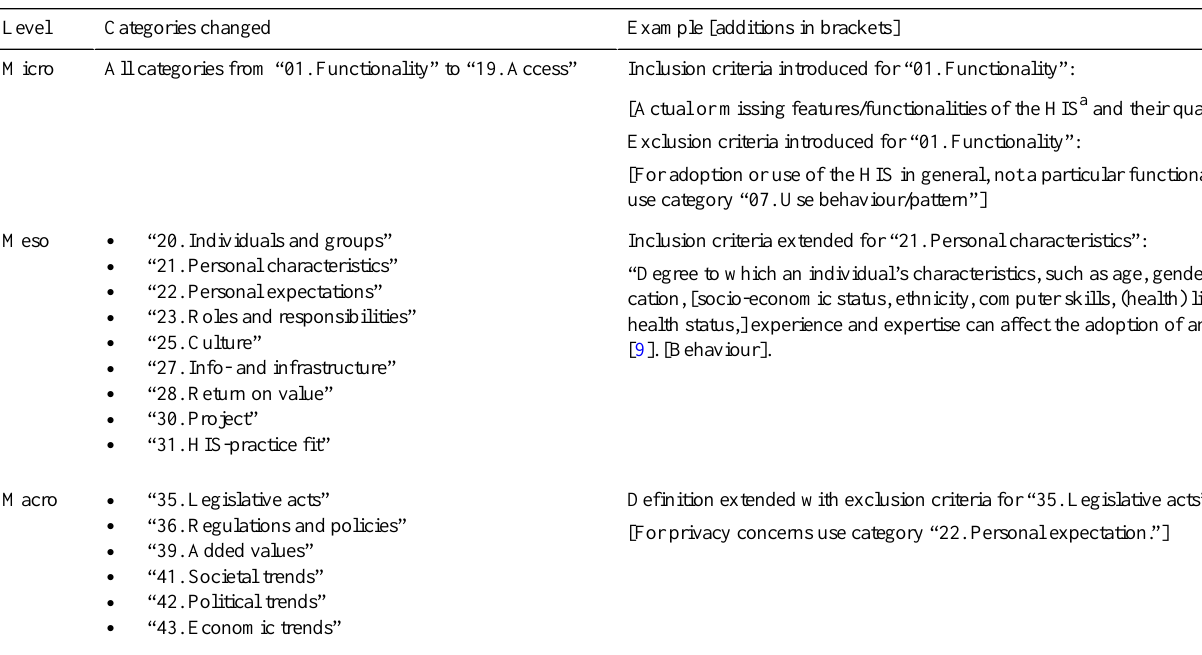
Table 2. Categories where inclusion and exclusion criteria were